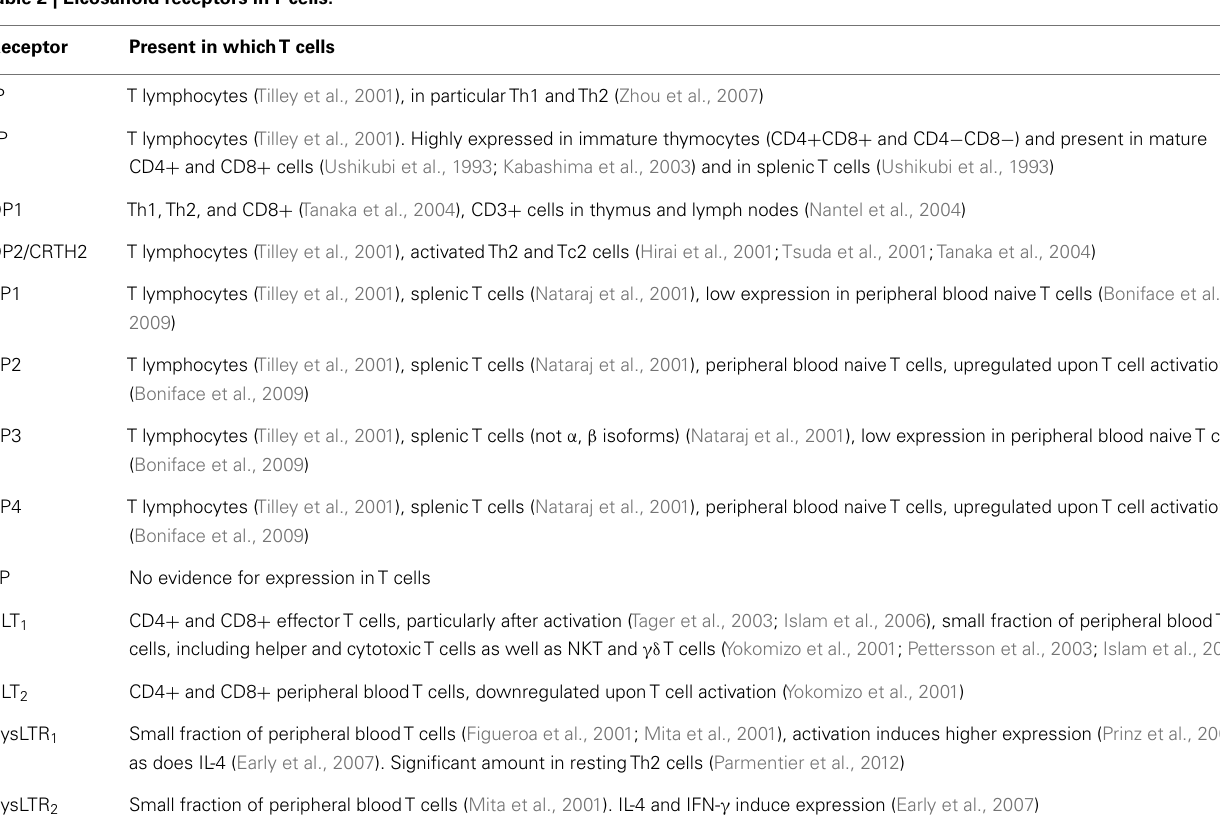
Table 2 | Eicosanoid receptors inT